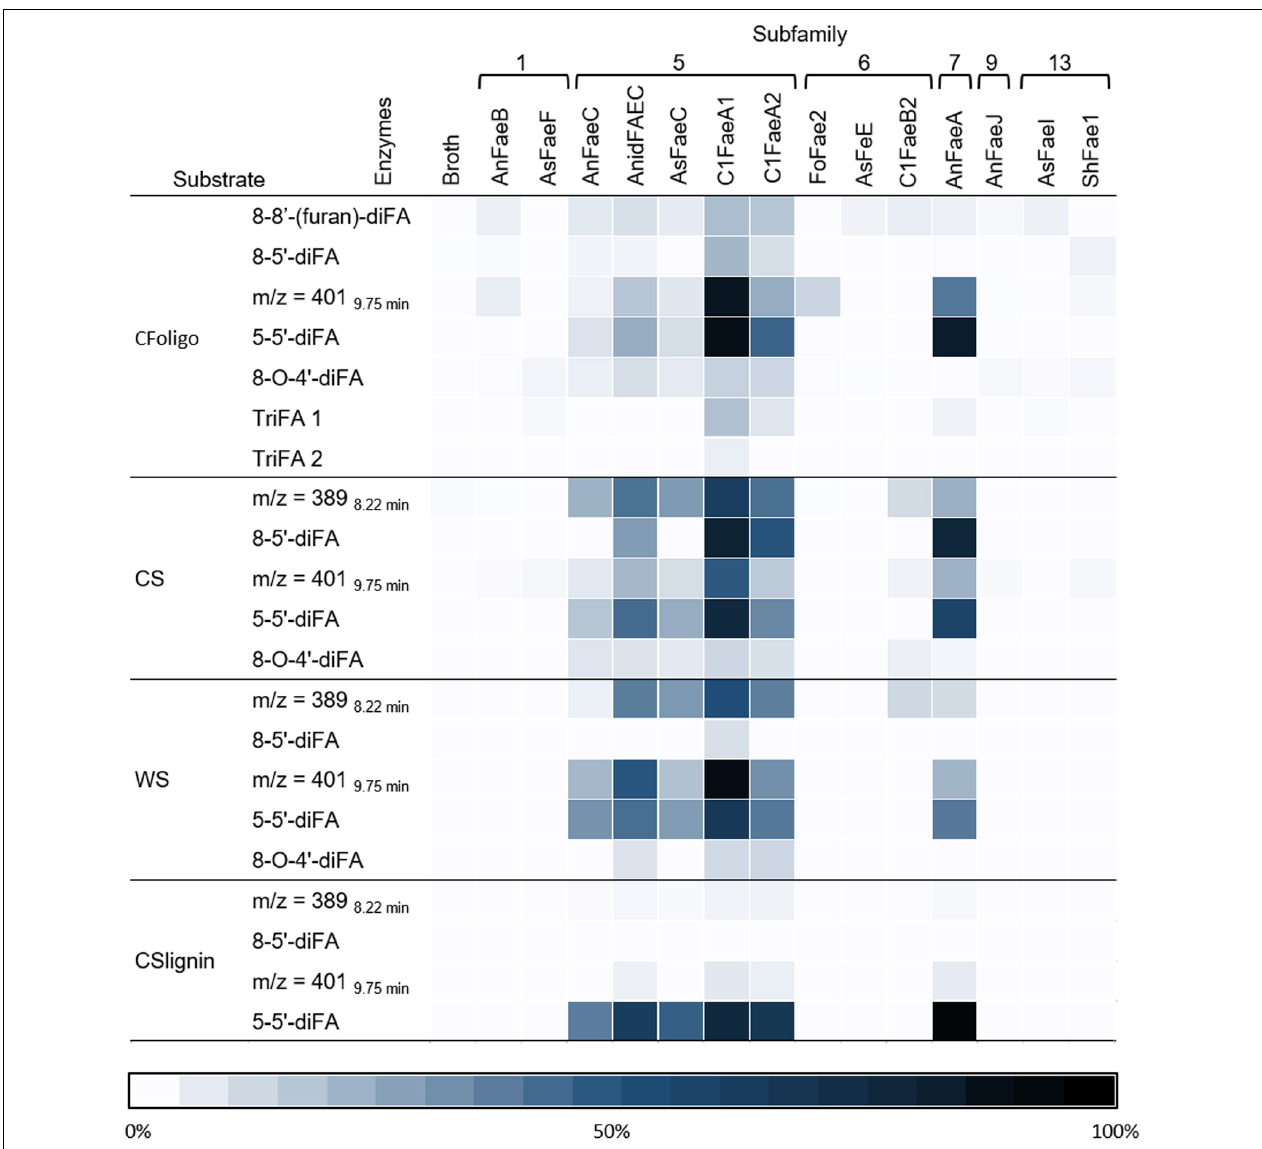
FIGURE 6 | Heatmap presenting the specificity of FAEs. This heatmap highlights the release of diFAs and triFAs by 14 FAEs (representing 6 SFs) from the PCW-derived and natural substrates corn fiber oligomers (CFoligo), corn stover (CS), wheat straw (WS), and corn stover lignin isolate (CSlignin). All substrates were incubated with FAEs and without (broth) at 37 ◦ C for 19 h in duplicate. The results are given as percentages of bound content as measured by RP-UHPLC-UV-ESI-MS/MS ( n = 2). The broth is the culture supernatant of P. pastoris which was grown without FAE insertion (negative